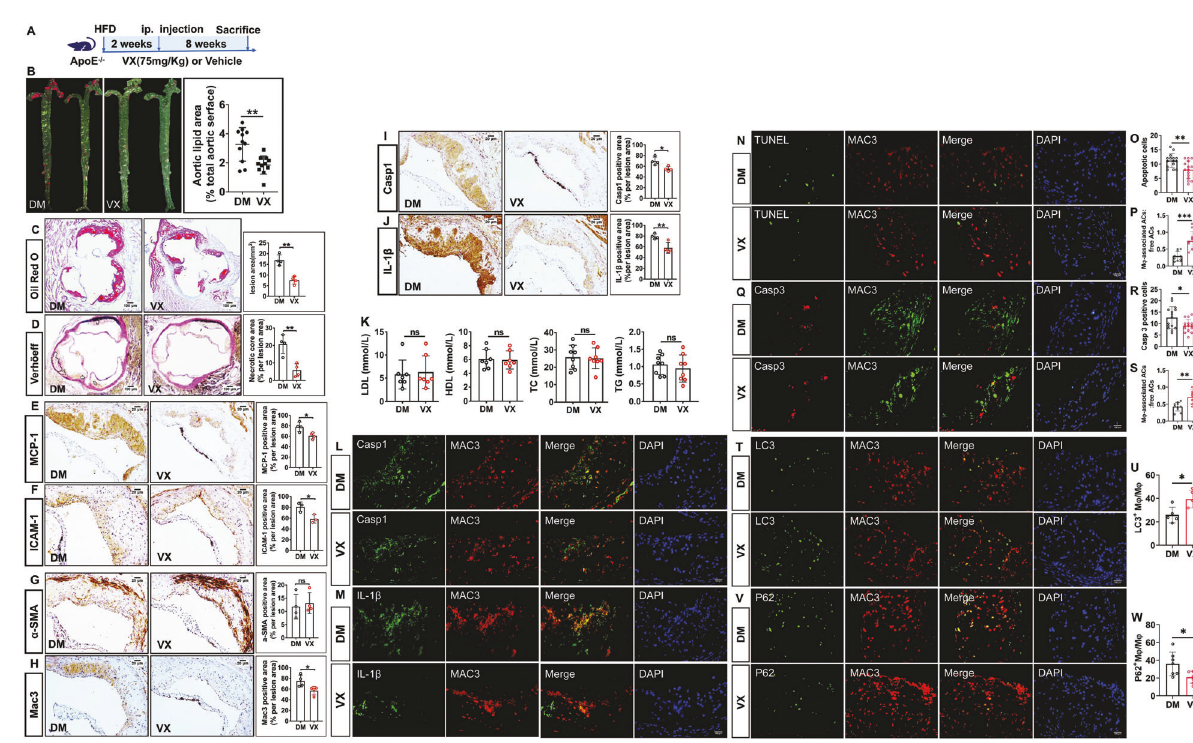
Fig. 6 VX765 restricts vascular in fl ammation and atherosclerosis in apolipoprotein E – de fi cient ( ApoE − / − ) mice. A Diagramed is the regimen for treatment of ApoE − / − mice (6 – 8 weeks old) with VX765 (VX, n = 11) or vehicle (DM, n = 11); B , C The atherosclerotic lesions in the whole aortas ( n = 11) and the aortic roots ( n = 4) were visualized by oil red O staining. D The necrotic regions were visualized by Verhöeff staining. E – J The expression of the indicated proteins in the aortic sinuses was detected by immunohistochemical staining. The positive area of each protein was measured. K The pro fi le of lipids and lipoproteins ( n = 3). L , M Double immunostaining of the indicated proteins in the aortic sinuses. N – S The expression of Caspase 3 and Mac3 was stained and quantitated to assess cell death and in situ macrophage efferocytosis. T – W Macrophage autophagy was assessed by immunostaining with the indicated antibodies and quantitated. HFD high-fat diet; ip intraperitoneal; LDL low-density lipoprotein; HDL high density lipoprotein; TC total cholesterol; TG total triglyceride; α -SMA α